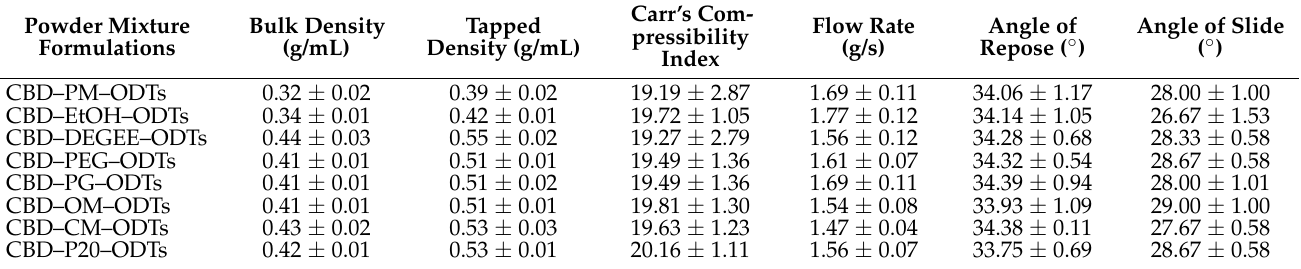
Table 2. Bulk density, tapped density, and flowability of CBD ODT bulk powder mixture. Powder Mixture